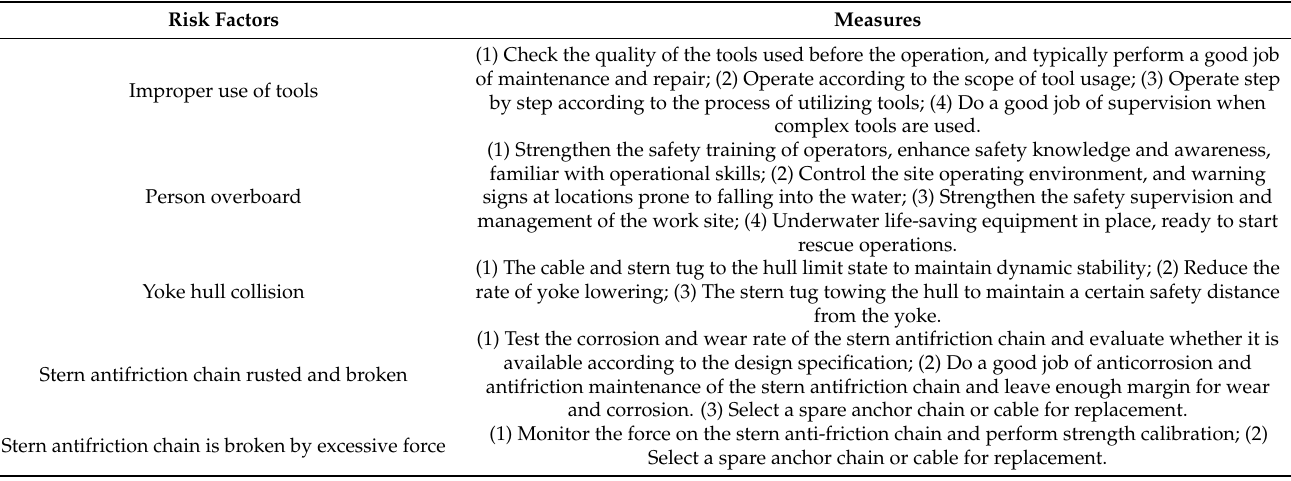
Table 12. Risk control measures for principal risk factors.